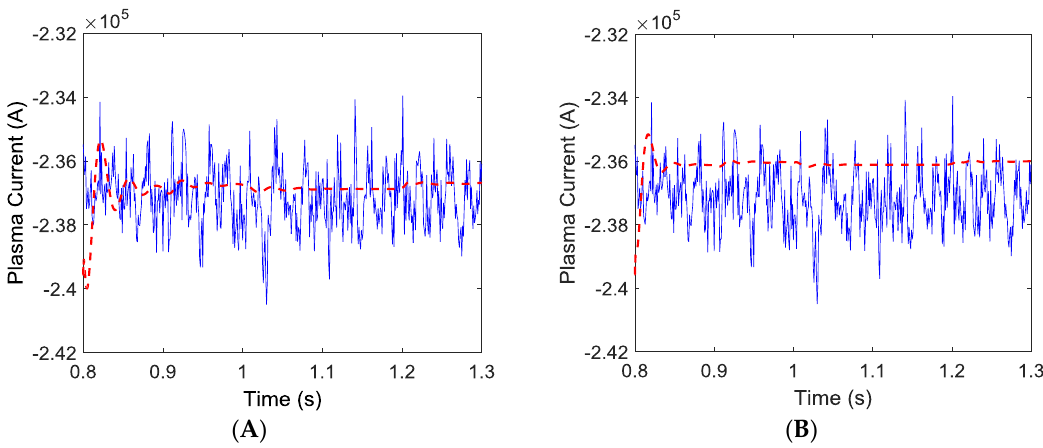
Figure 5. Plasma current: RZIp measured values (PID), blue (-) lines. Hybrid MPC RZIp computed values with N p = 9 and N c = 5 , red (- -) ( A) and using a hybrid MPC with 𝑁 𝑝 = 9 and 𝑁 𝑐 = 2 ( B ).